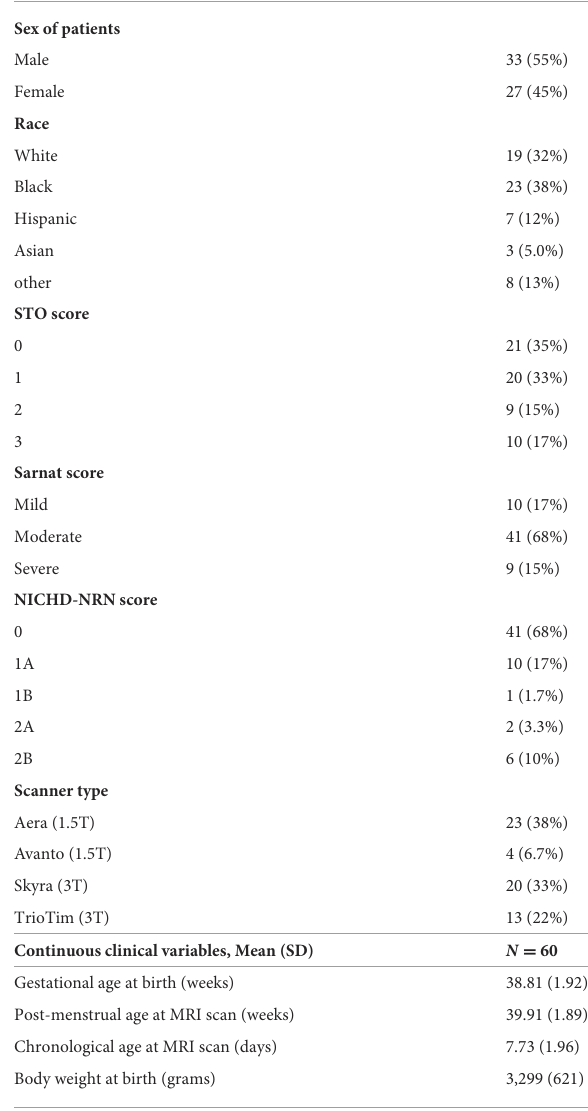
TABLE 1 Clinical characteristics of 60 neonatal HIE patients who underwent therapeutic hypothermia treatment. Categorical clinical variables, n / N